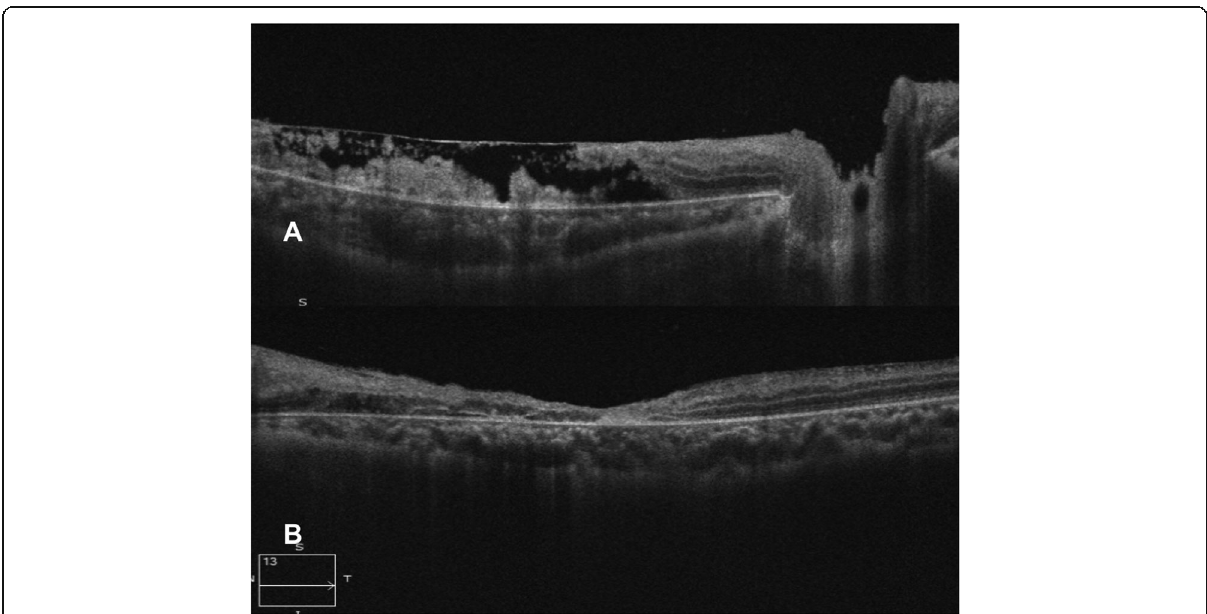
Fig. 3 a SD-OCT of the RE showing loss of retinal architecture with moth eaten appearance of the retina. b SD-OCT of the LE showing loss of retinal architecture with foveal